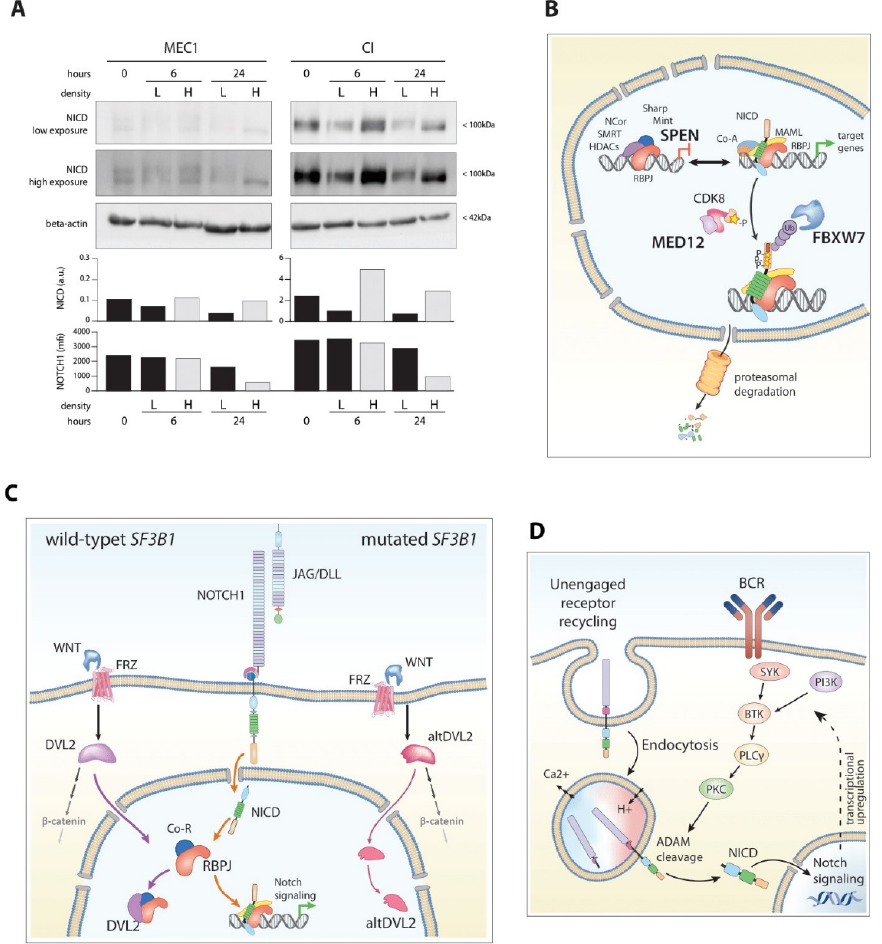
Figure 4. Other mutation-independent mechanisms of NOTCH1 in CLL. ( A ) NOTCH1 activation is mostly dependent upon microenvironmental interactions. Immunoblot and flow cytometric detection of NICD in NOTCH1 -wild-type (MEC1) and NOTCH1 -mutated (3′UTR mutation, CI) CLL-like cell lines, cultured at low (L, 0.054 × 10 6 cells/cm 2 ) and high (H, 3 × 10 6 cells/cm 2 ) concentration for the indicated time. Samples at time zero were collected after an overnight culture at low concentration. For the high exposure blot, a gamma correction of 0.5 was applied to enhance visibility. Blots are derived from one single gel and are separated only for presentation purposes.